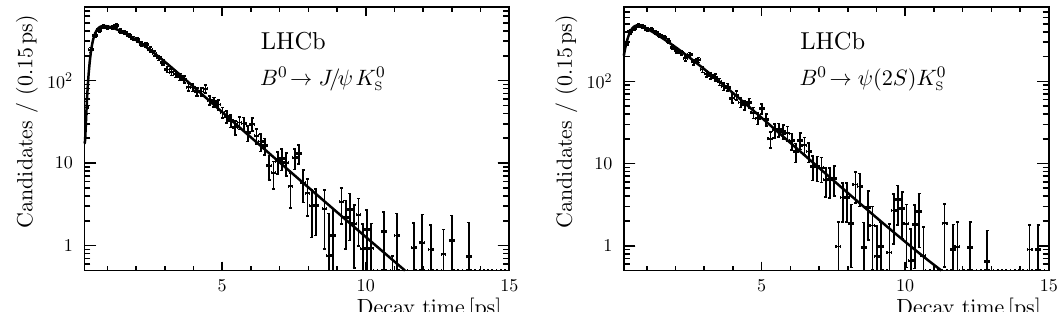
Figure 2 . Projections of the decay-time (cid:12)t to weighted (left) B 0 ! J= K 0 B 0 ! (2 S ) K 0 S